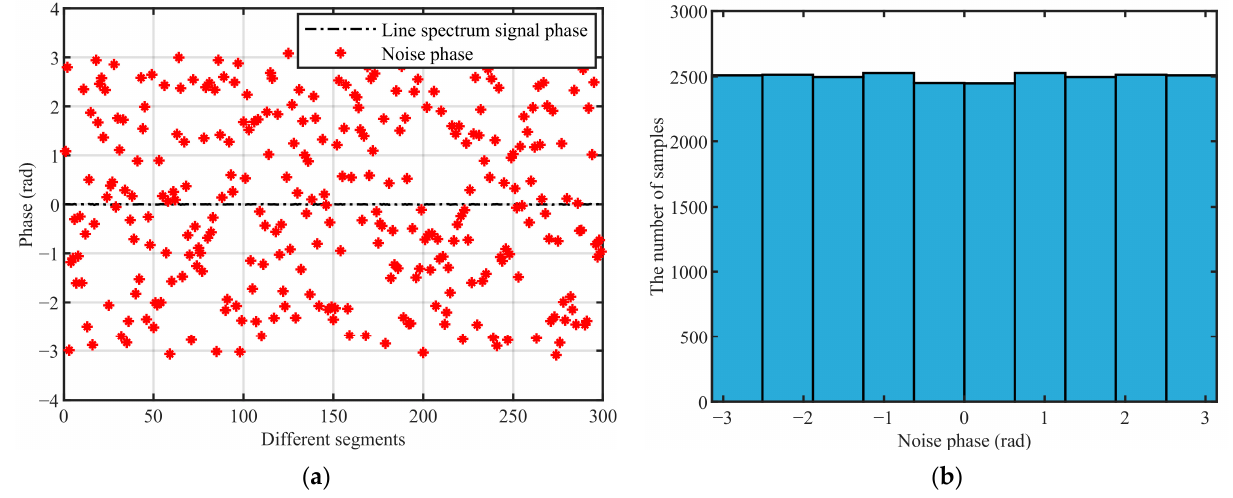
Figure A1. Phase distribution on the power spectrum: ( a ) phase variation with segment; ( b ) noise phase histogram.